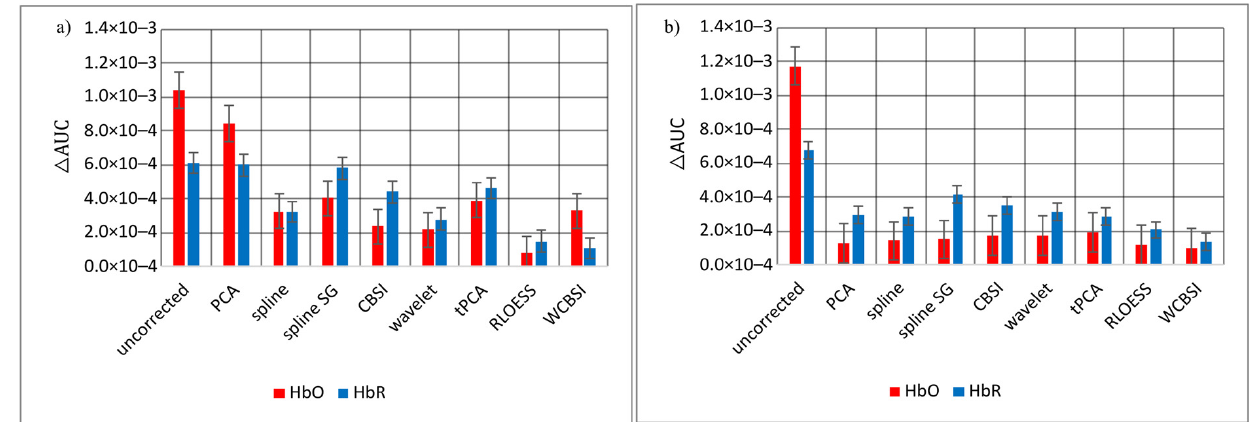
Figure 9. Mean difference between areas under curve ( △ AUC) of the MA corrected HbO and HbR signals and their respective reference signals. This is shown in ( a ) for the SHM responses and in ( b ) for the LHM responses. The △ AUCs were calculated individually for each participant and then averaged. Error bars indicate standard error across participants.